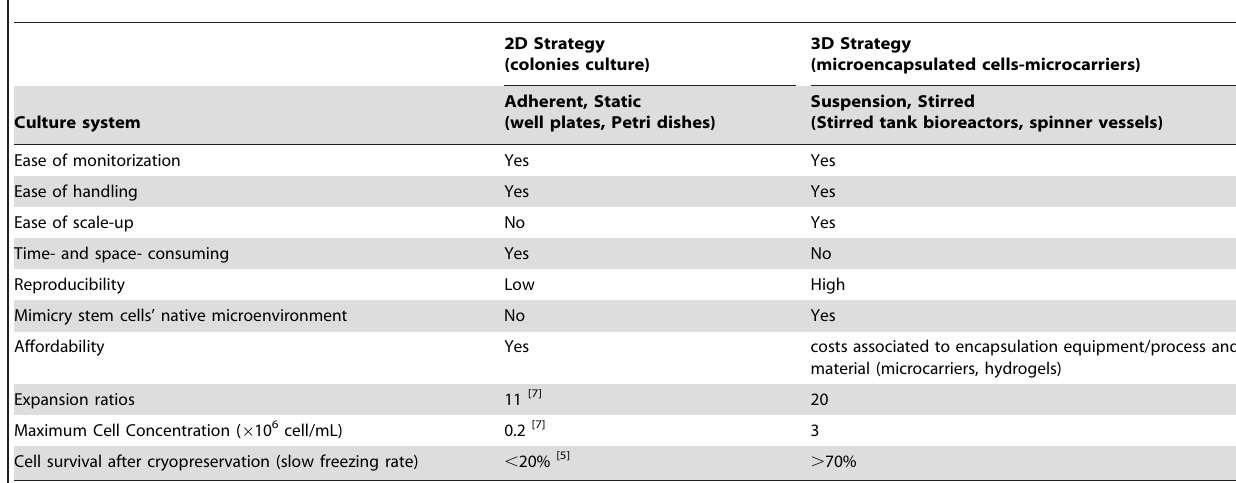
Table 2. Characteristics and bioprocess yields of the 3D strategy and the standard 2D protocols.